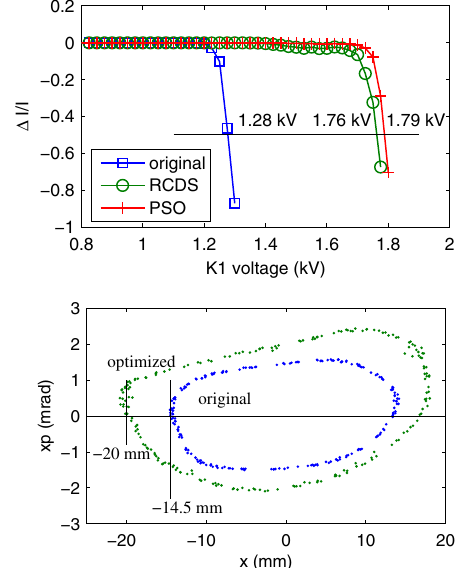
FIG. 3. Comparison of measured dynamic aperture for the original and optimized solutions. original and optimized solutions are 15.1 and 20.6 mm, respectively.